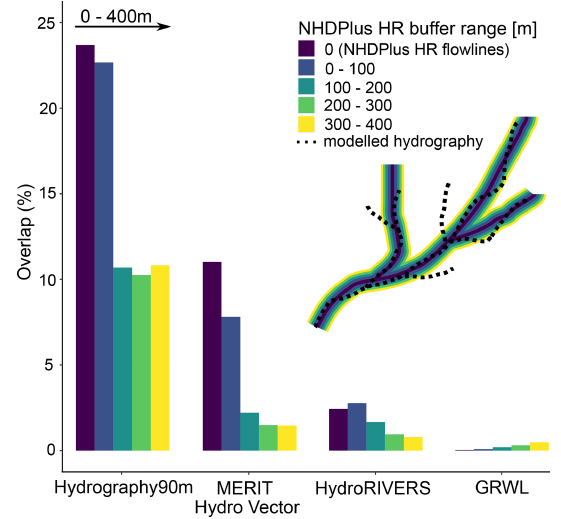
Figure 8. Comparison of the spatial accuracy of the newly de- veloped Hydrography90m and the MERIT Hydro-Vector, HydroR- IVERS, and GRWL datasets against NHDPlus HR. The inset shows the validation method: we first buffered NHDPlus HR by 100, 200, 300, and 400m (see corresponding colours) and then calculated the fraction of overlapping stream grid cells between NHDPlus HR and each dataset. The latter are illustrated here as dotted